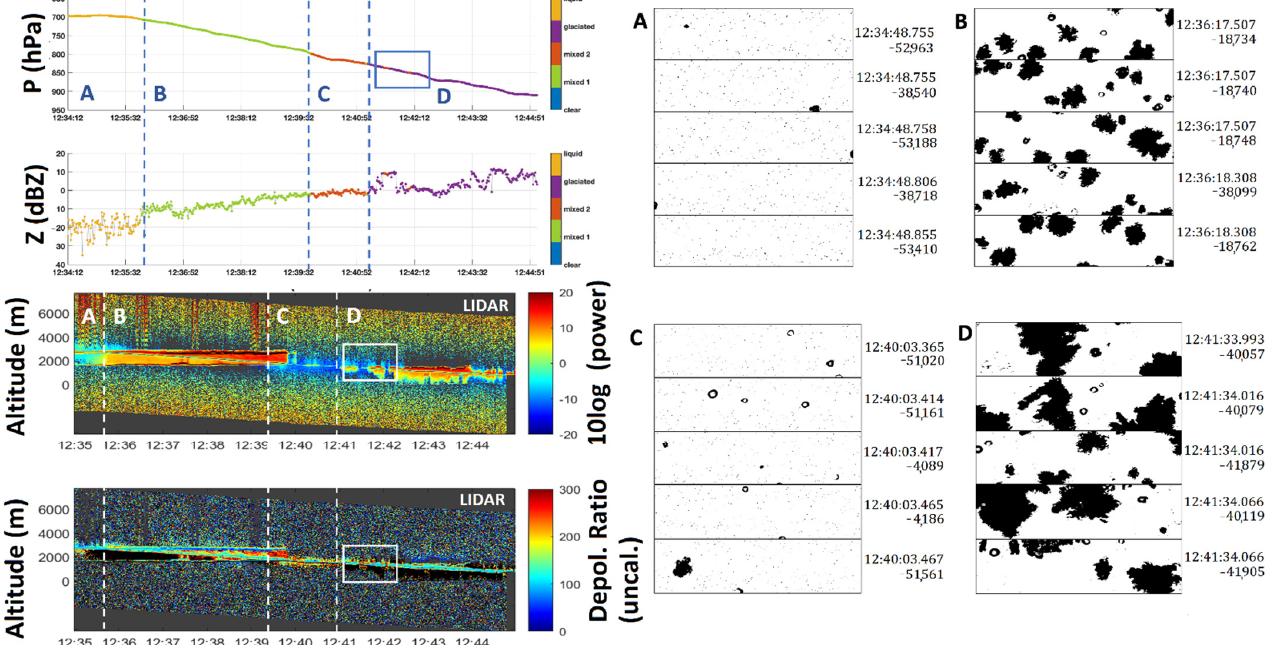
Figure 13. NRC Convair-580 aircraft pressure-altitude flight profile and W-band radar reflectivity ( Top ), lidar reflectivity and depolarization plots ( Bottom ), 2D-S images for 4 selected time intervals ( Right ) from 12:34 to 12:45 UTC on 5 March 2019 (F28).